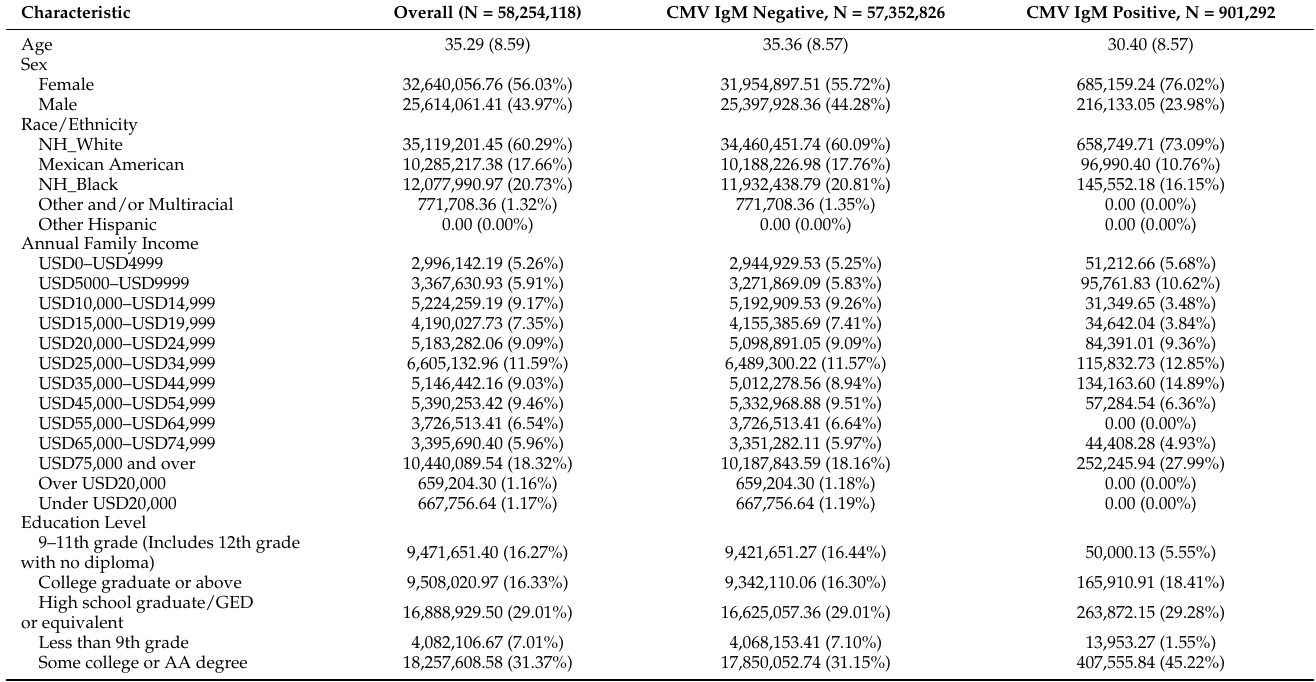
Table 2. Means (standard error) of critical variables by acute CMV exposure status (IgM+/IgM −